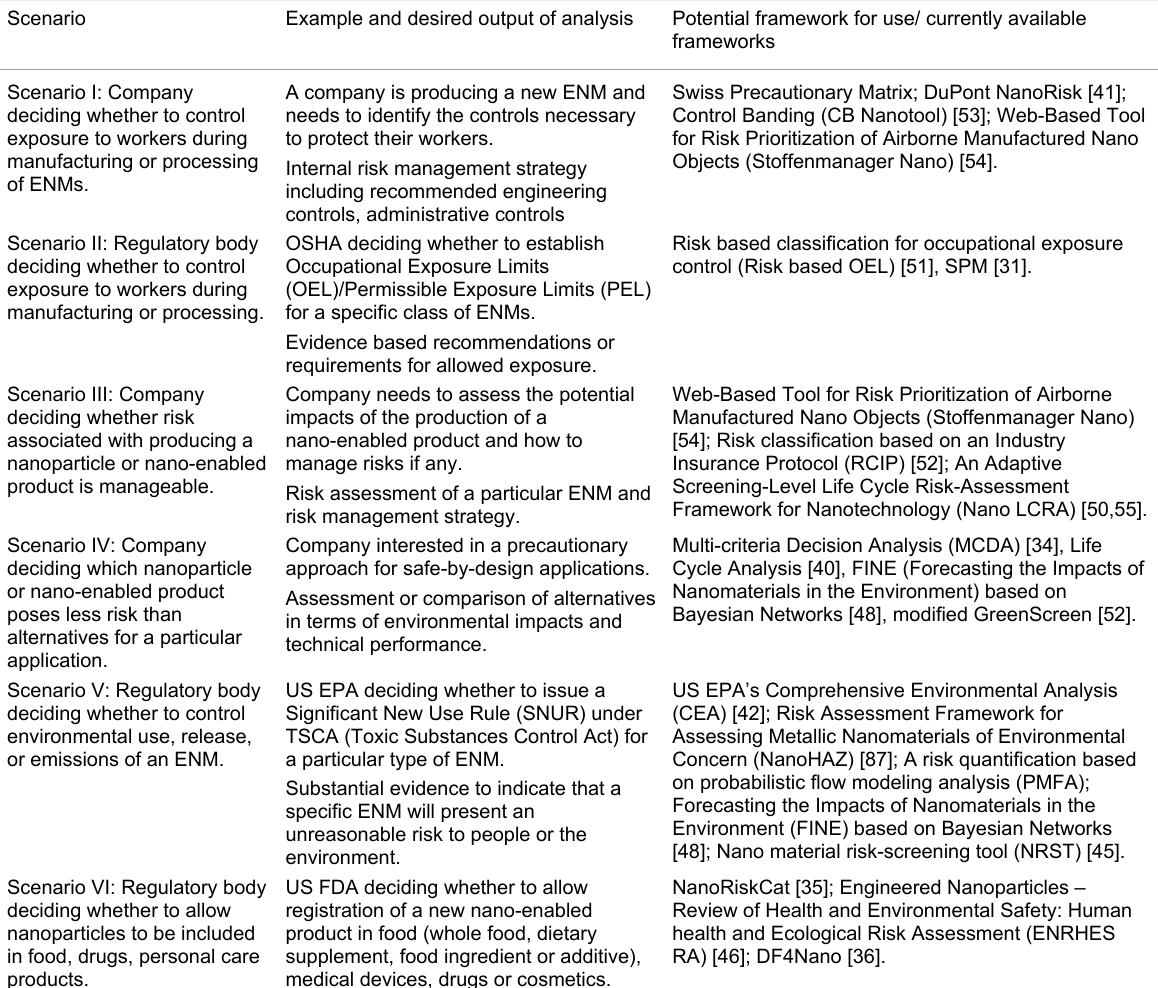
Table 2: Decision needs and recommended ENMs relevant risk assessment frameworks for selected regulatory decision-making scenarios. Scenario Example and desired output of